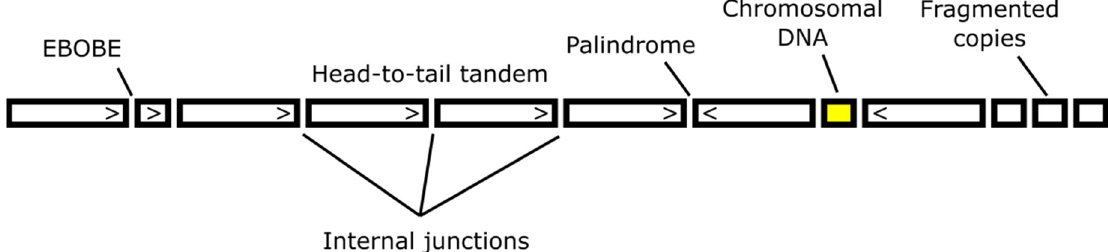
Figure 2. Concatemer elements that could be present at the integration site (see explanations in the text).